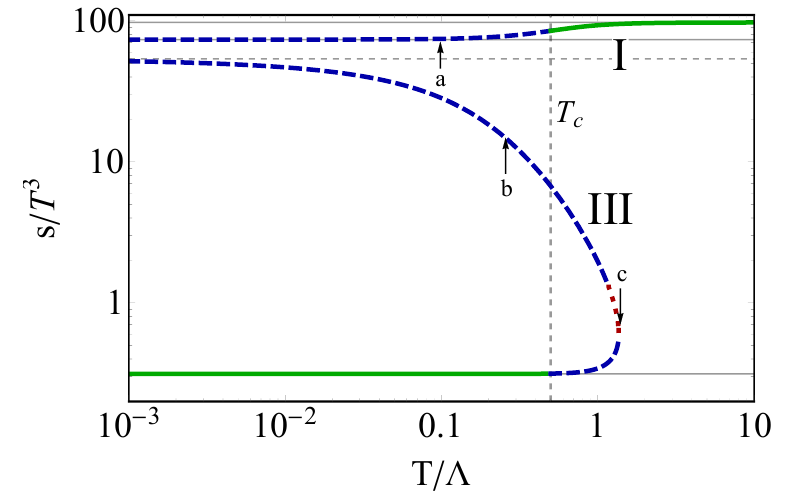
Figure 5 . Some explicit examples of numerical solutions for the bulk geometry. We present three examples, one of them with (cid:30) H in region I (case a) and two in region III (cases b and c). Each gravity solution is dual to a thermal state in the CFT 1 .